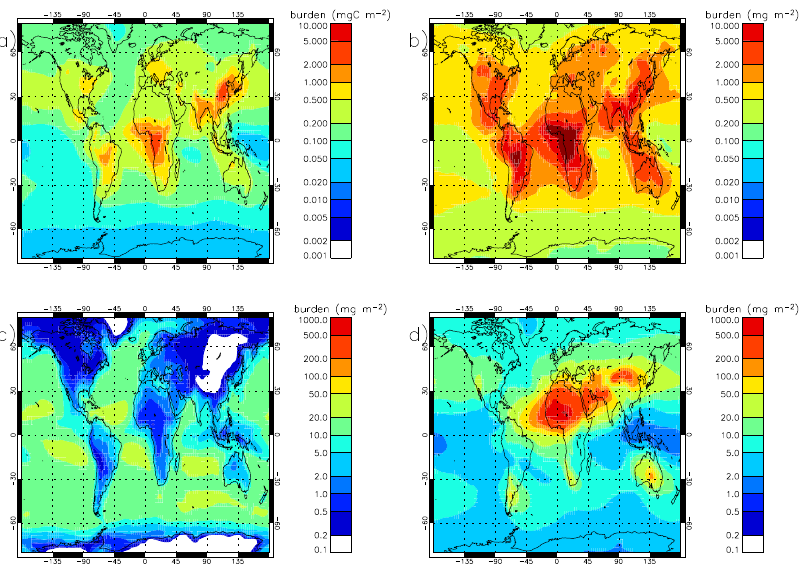
Fig. 4. Global maps of annual mean model column-integrated aerosol burden of (a) black carbon, (b) particulate organic matter, (c) sea-salt and (d)